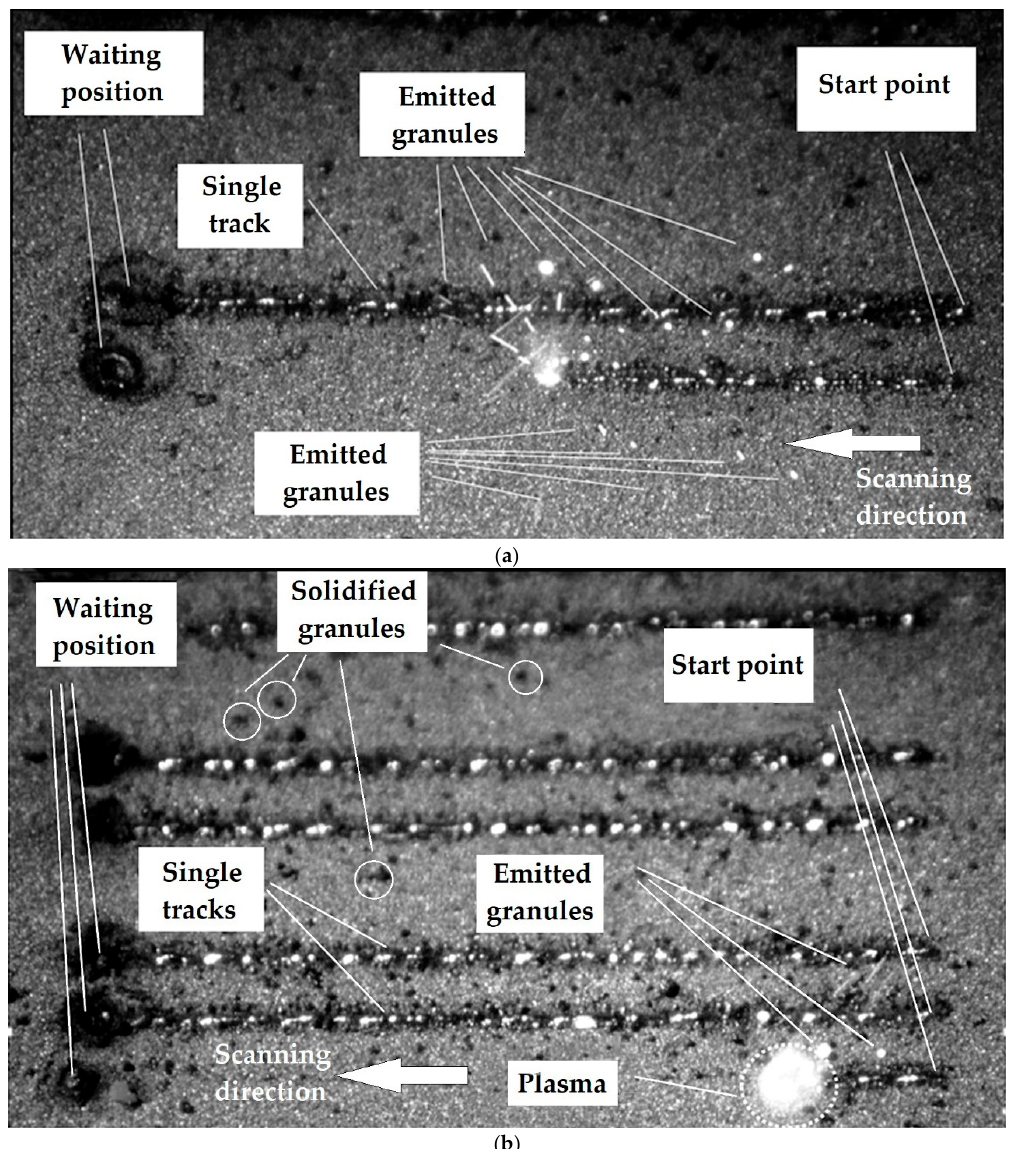
Figure 13. The result of video monitoring of SLM processing of CoCrMo powder (granule diameter d < 50 µm) by high-speed camera with 810 nm filter: ( a ) SLM parameters: nominal laser power P = 32 W, scanning speed V = 15 mm/s, thickness of the layer h = ~80 µm; ( b ) SLM parameters: nominal laser power P = 50 W, scanning speed V = 15 mm/s, thickness of powder layer h = ~80 µm.